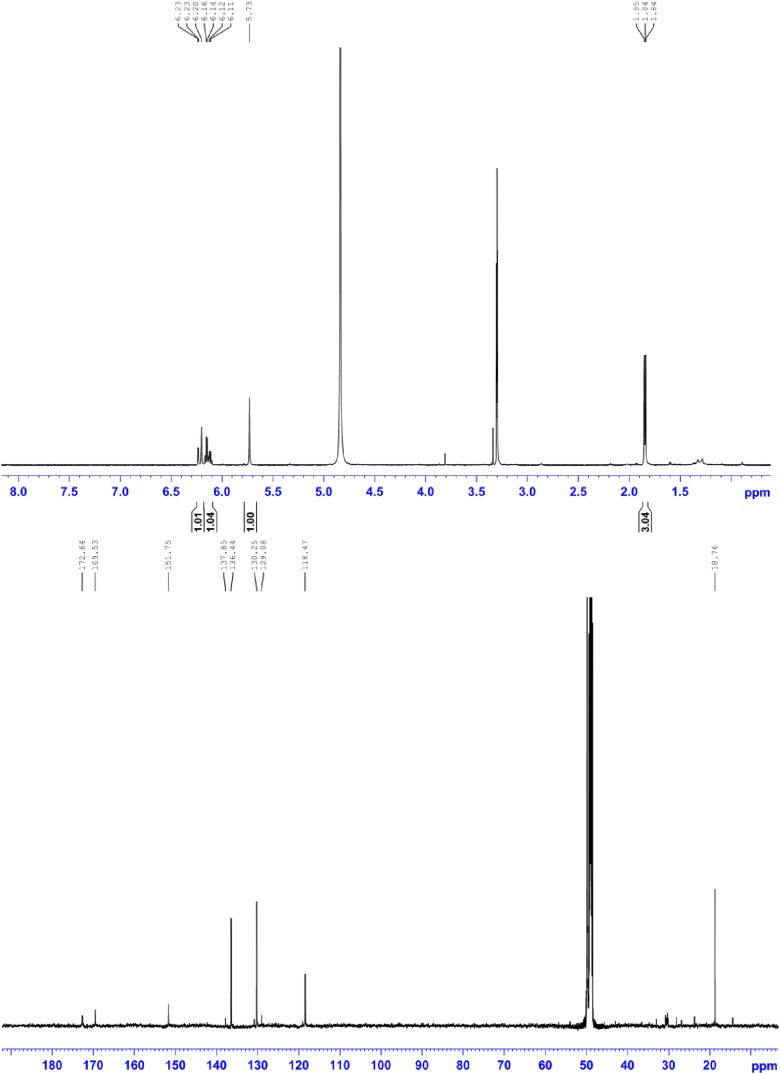
1H NMR (500 MHz, MeOD; upper panel) and 13C NMR (150 MHz, MeOD; lower panel) of compound 4, 2-((E)-prop-1-en-1-yl)maleic acid.1H NMR (500 MHz, MeOD): δ 6.22 (1H, d, 3J = 15.8 Hz), 6.15 (1H, dq, 3J = 15.8 Hz, 3J = 6.5 Hz,), 5.73 (1H, s), 1.85 ppm (3H, d, 3J = 6.5 Hz); 13C NMR (600 MHz, MeOH): δ 172.6, 169.5, 151.7, 136.4, 130.2, 118.5, 18.8 ppm; HRMS: (ESI+): m/z calculated for C7H9O4: 157.0495, found 157.0495 [M + H]+.